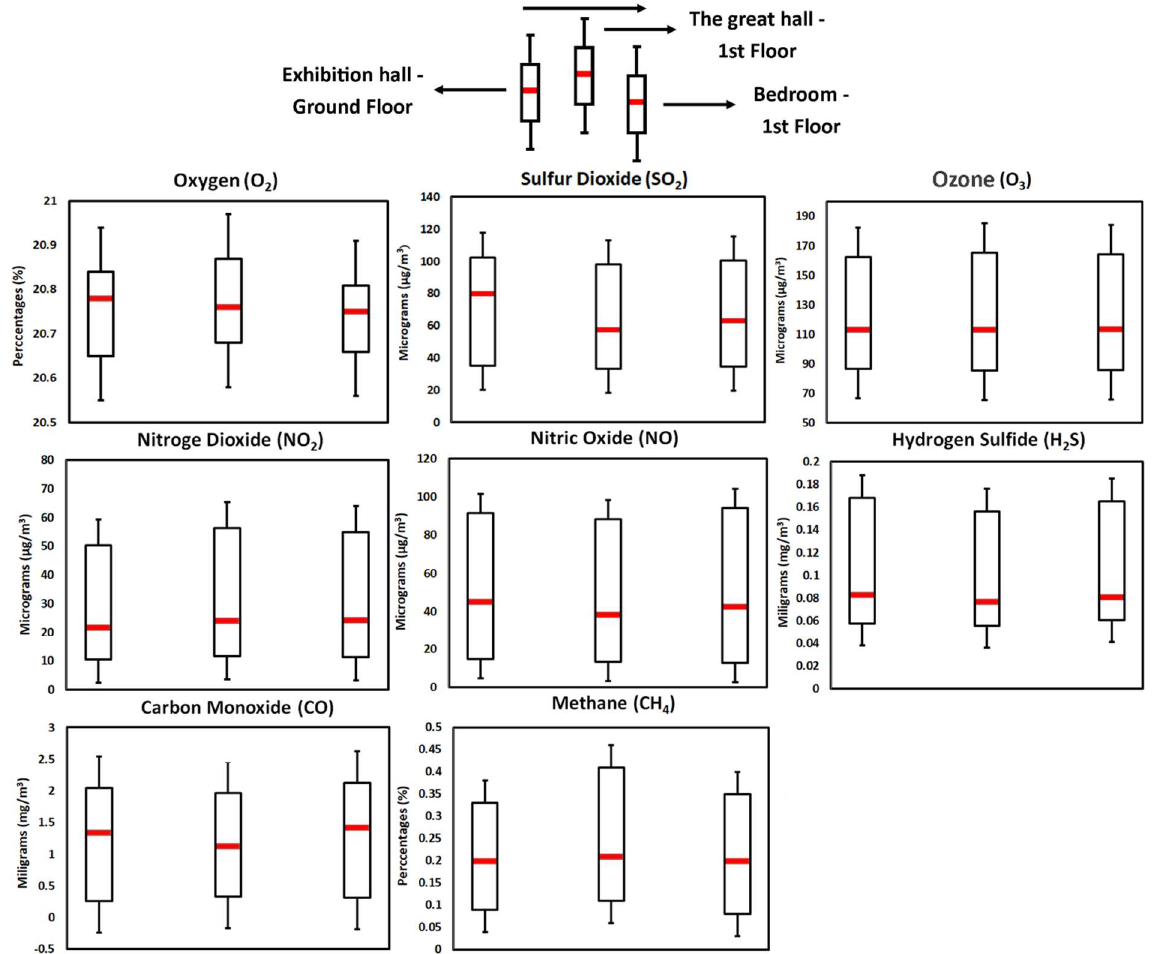
Figure 10. The minimum, maximum and average concentrations of O 2 , SO 2 , O 3 , NO 2 , NO, H 2 S, CO and CH 4 in the three monitored rooms of the Darvas-La Roche